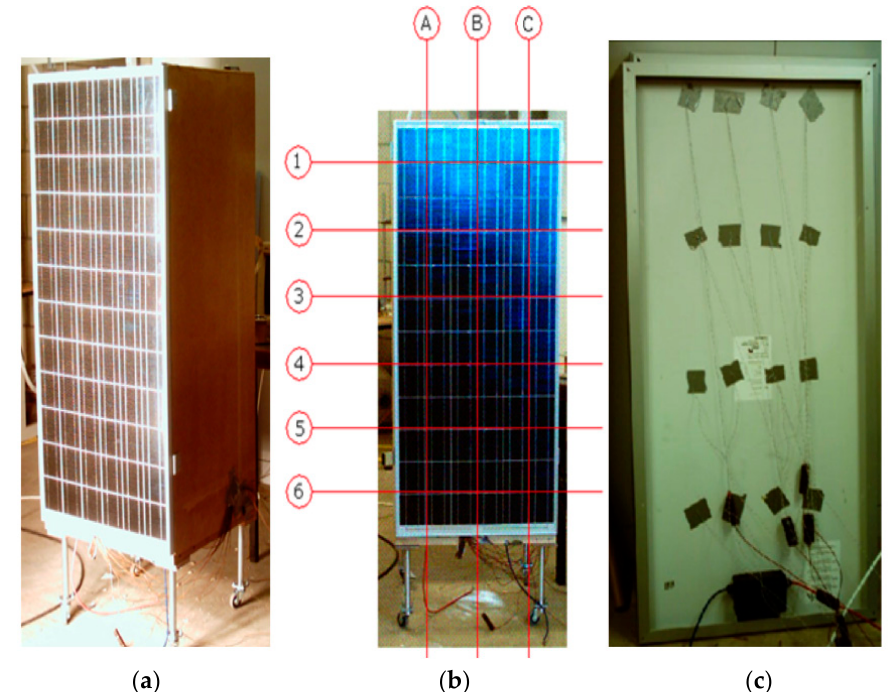
Figure 1. ( a ) PV panel fixed to a duct and raised by 50 cm on 4 tubes. ( b ) Light measured at grid points in front of PV panel. ( c ) Thermocouples connected to the back of PV panel.